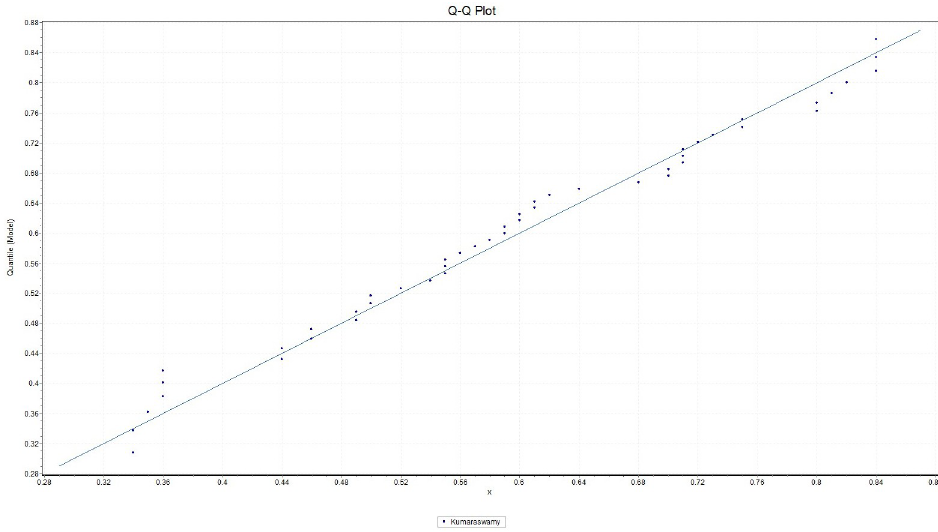
Fig 10. Plot of the empirical quantile of Kumaraswamy distribution fitted to the patient relief times.